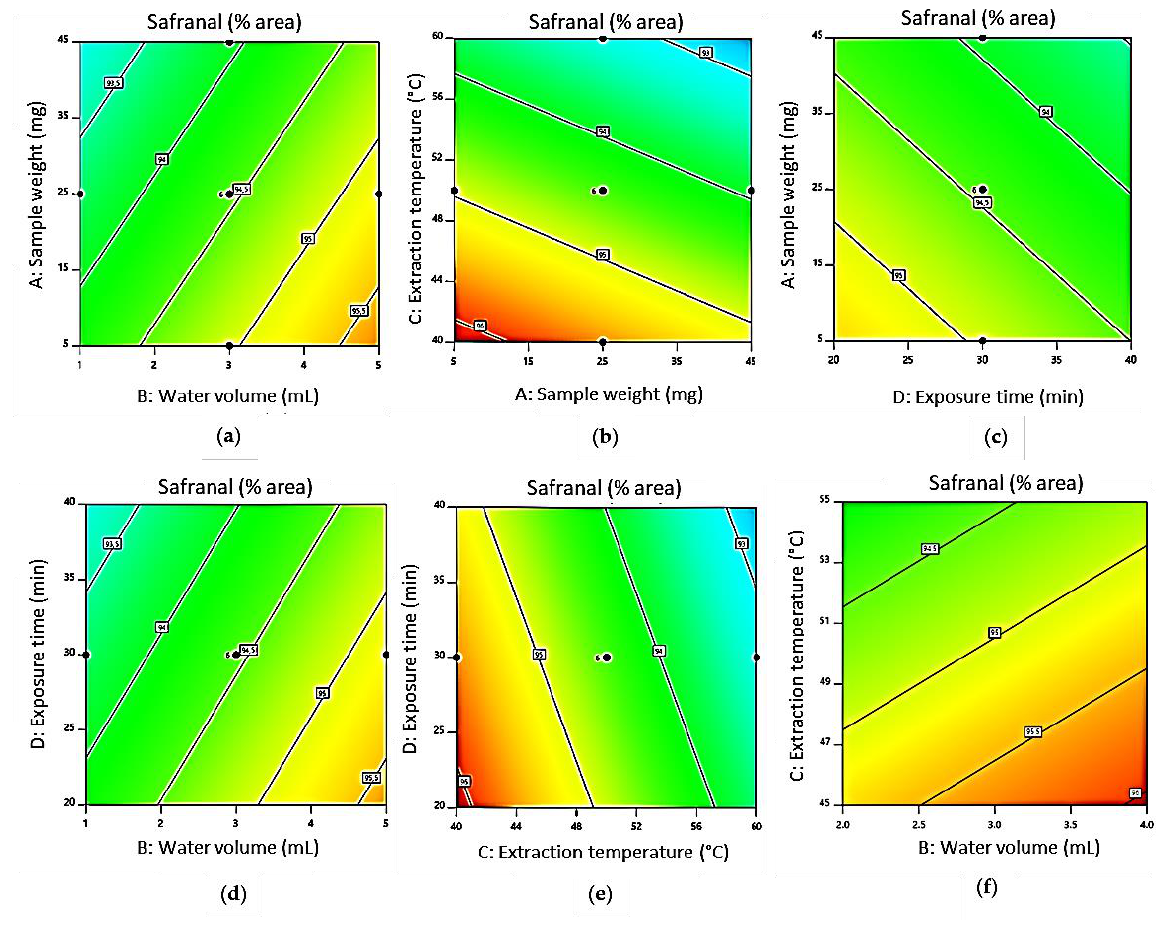
Figure 3. Contour plots of the interaction between; ( a ) sample weight and water volume; ( b ) sample weight and temperature; ( c ) sample weight and exposure time; ( d ) exposure time and water volume; ( e ) exposure time and extraction temperature; ( f ) extraction temperature and water volume.